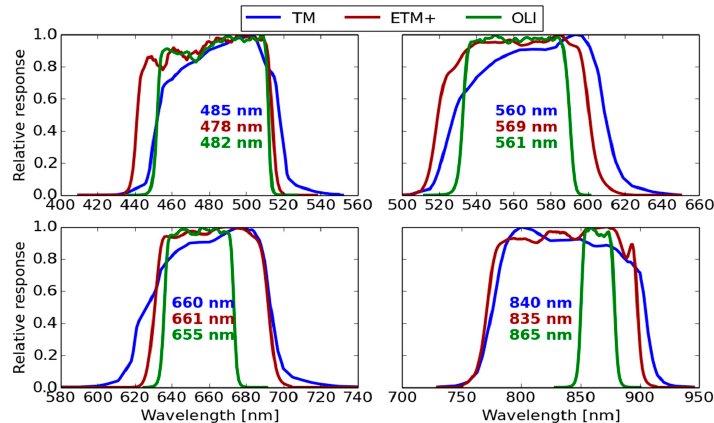
Figure 1. The relative spectral response (RSR) for the Thematic Mapper (TM), the Enhanced Thematic Mapper Plus (ETM+), and the Operational Land Imager (OLI) with their corresponding nominal center wavelength. The largest difference between TM/ETM+ and OLI is in the near infrared (NIR) channel where OLI band was designed narrow to avoid water-vapor absorption in the atmosphere.